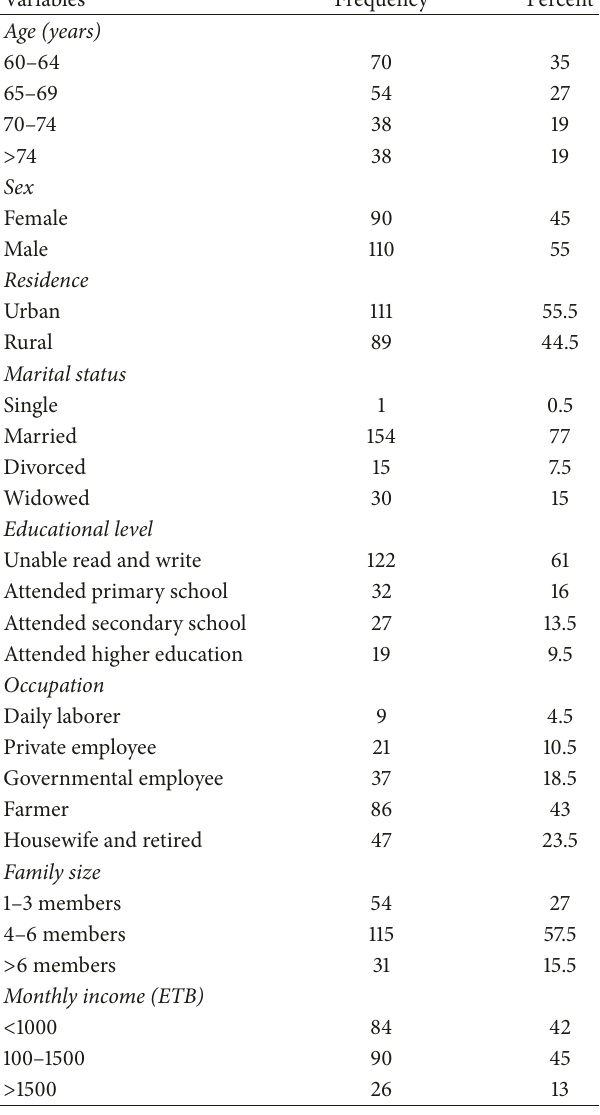
Table 1: Sociodemographic characteristics of study participants ( 𝑛 = 200